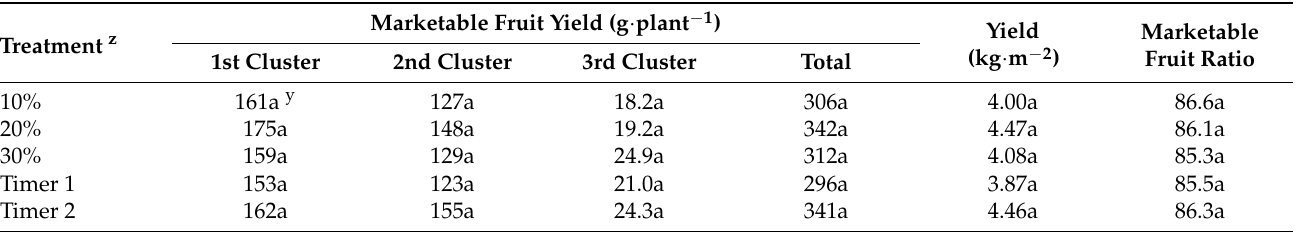
Figure 6. Correlation among nutrient contents in the aerial ( a ) and root ( b ) parts of strawberry ‘Kuemsil’ affected by the nutrient solution supplying system using different drainage rate levels and timings. Asterisks indicate significant differences according to Duncan’s multiple range test at p < 0.05 (*), 0.01 (**) and 0.001 (***). Table 2. Marketable fruit yield (above 12 g) characteristics of strawberry ‘Kuemsil’ affected by the nutrient solution supplying system using different drainage rate levels and